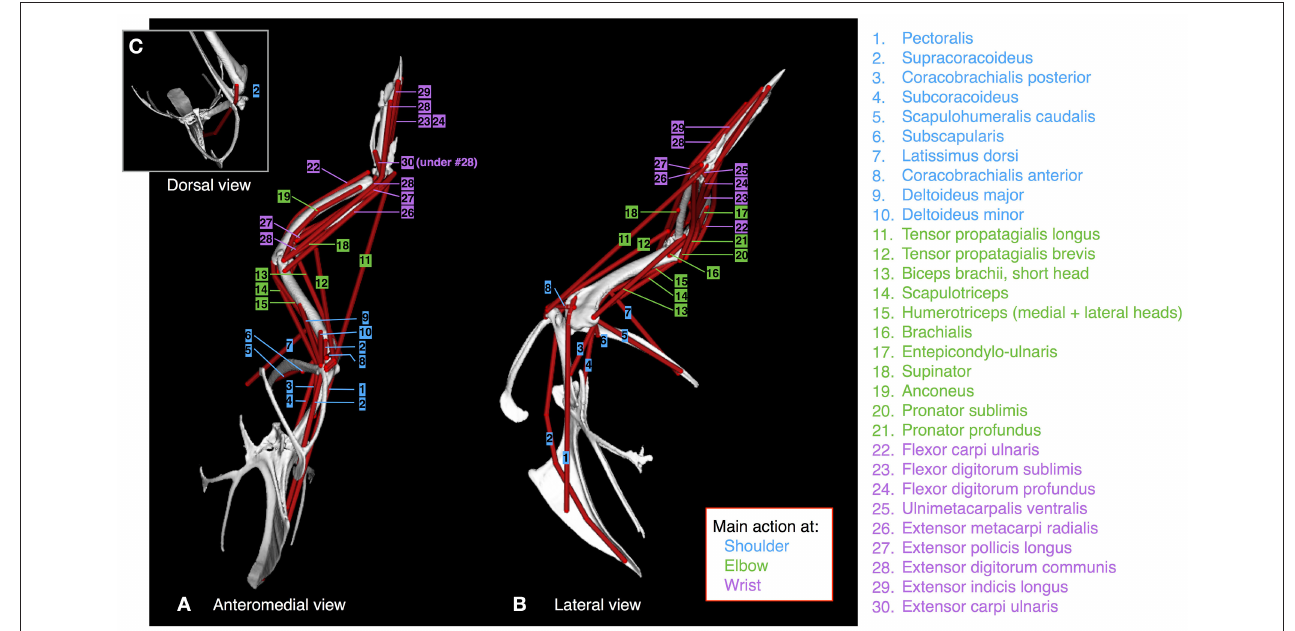
FIGURE 2 | Muscles. Origins, paths, and insertions of the 30 forelimb muscles modeled. Muscles acting mainly at the shoulder are numbered in blue; muscles acting mainly at the elbow are numbered in green; muscles acting mainly at the wrist are numbered in purple. (A) adult model in anteromedial view, (B) adult model in left lateral view, (C) adult model in dorsal